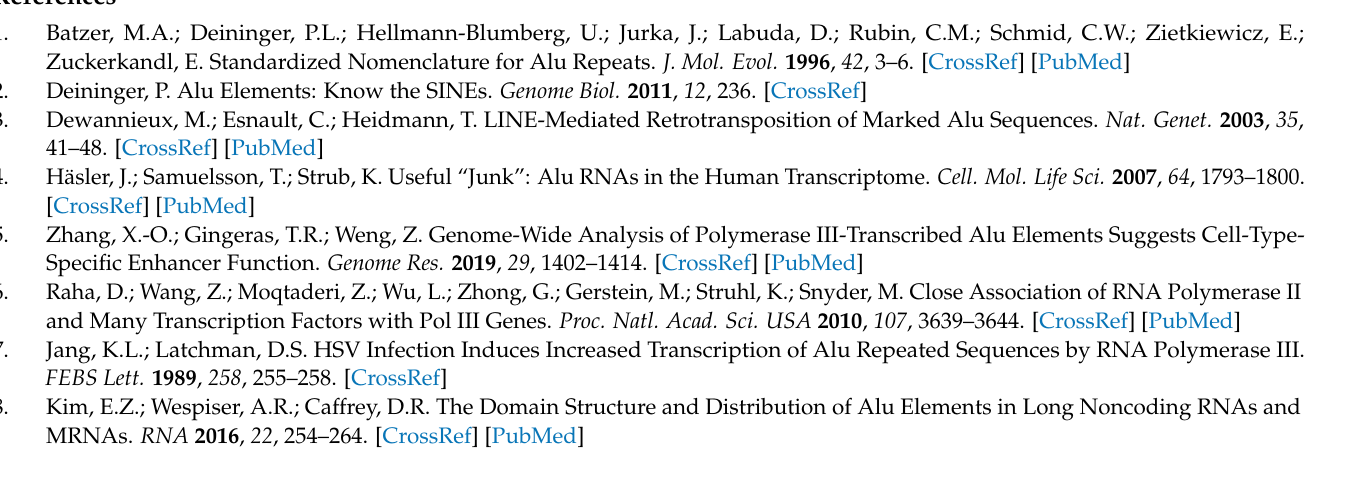
Table S3: 850_Alu_insertion_400_cutoff_Taizhou_study, Table S4: